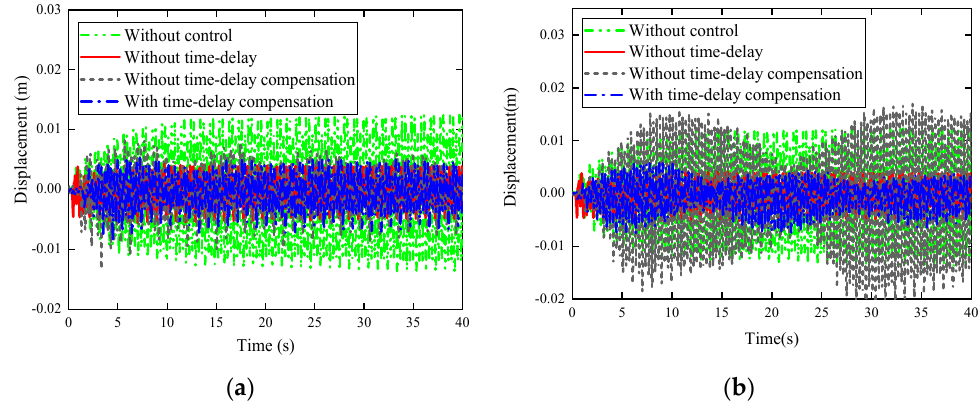
Figure 11. The experimental displacement at mid-span with time-delay under harmonic excitation. ( a ) The time-delay is 0.11 s. ( b ) The time-delay is 0.13 s. Table 6. Experimental response reductions at mid-span under harmonic excitation. Table 5. Experimental response reductions at mid-span under free